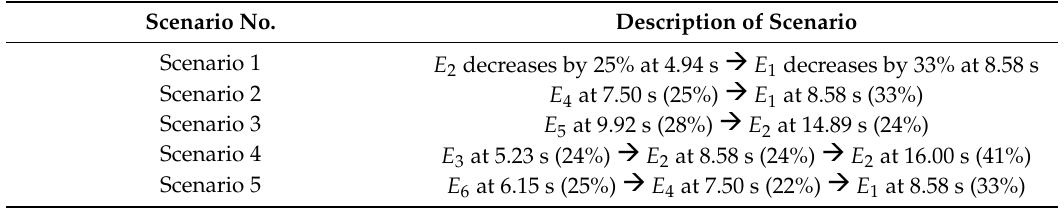
Table 2. Damage scenarios based on simulated peak relative displacements in Table 1.